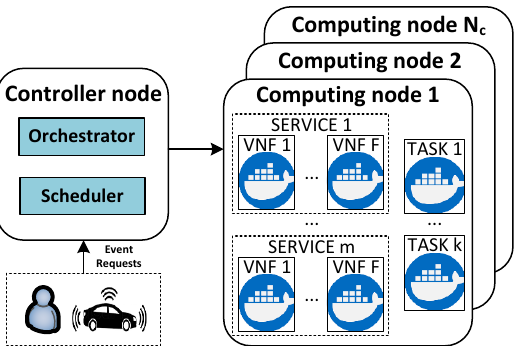
Figure 1. Reference architecture formed by a controller node and multiple computing